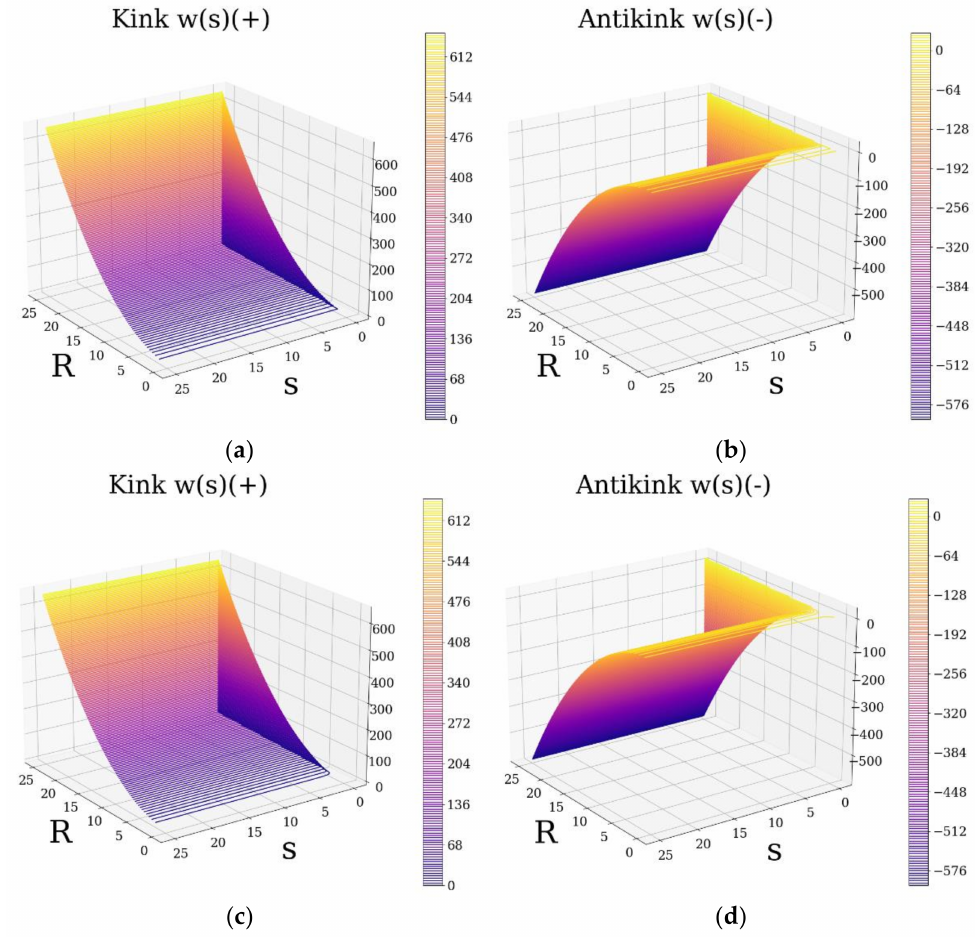
Figure 3. Plot of kink-antikink w ( s ) : ( a ) Kink, M = 0.02, K = 1; ( b ) Antikink, M = 0.02, K = 1; ( c ) Kink, M = 2, K = 1; ( d ) Antikink, M = 2, K =